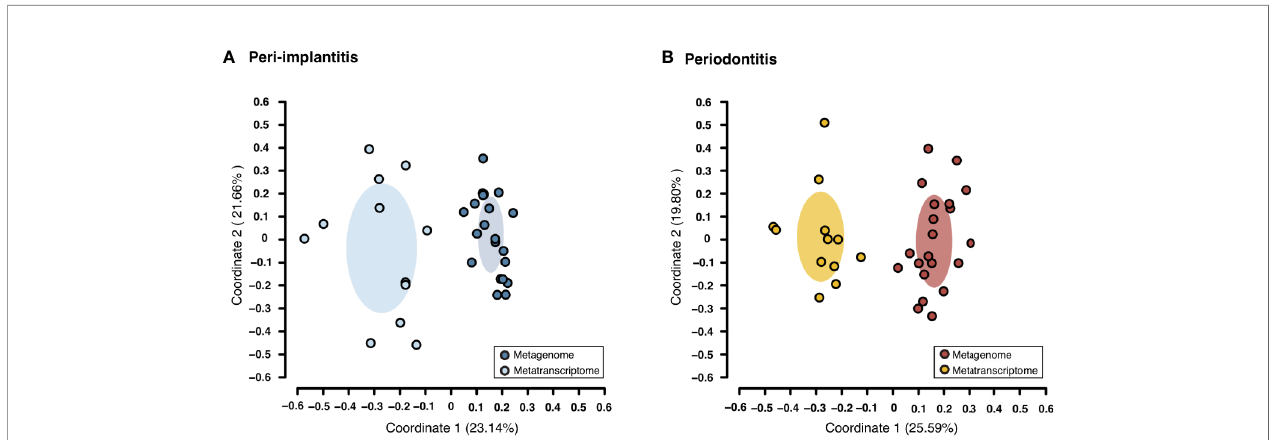
FIGURE 1 | Taxonomic pro fi le derived from genes comparing the metagenome and metatranscriptome. Principal coordinate analysis (PCoA) was carried out for the dissimilarity matrix value of 1 — Spearman ’ s coef fi cient. The CDS and mRNA abundances from only species detected in both 16S and mRNA region analyses in the same subject were used in this analysis. (A) PCoA plots among peri-implantitis samples compared between DNA (blue circles) and RNA (light blue circles), (B) among periodontitis samples compared between DNA (red circles) and RNA (light red circles).